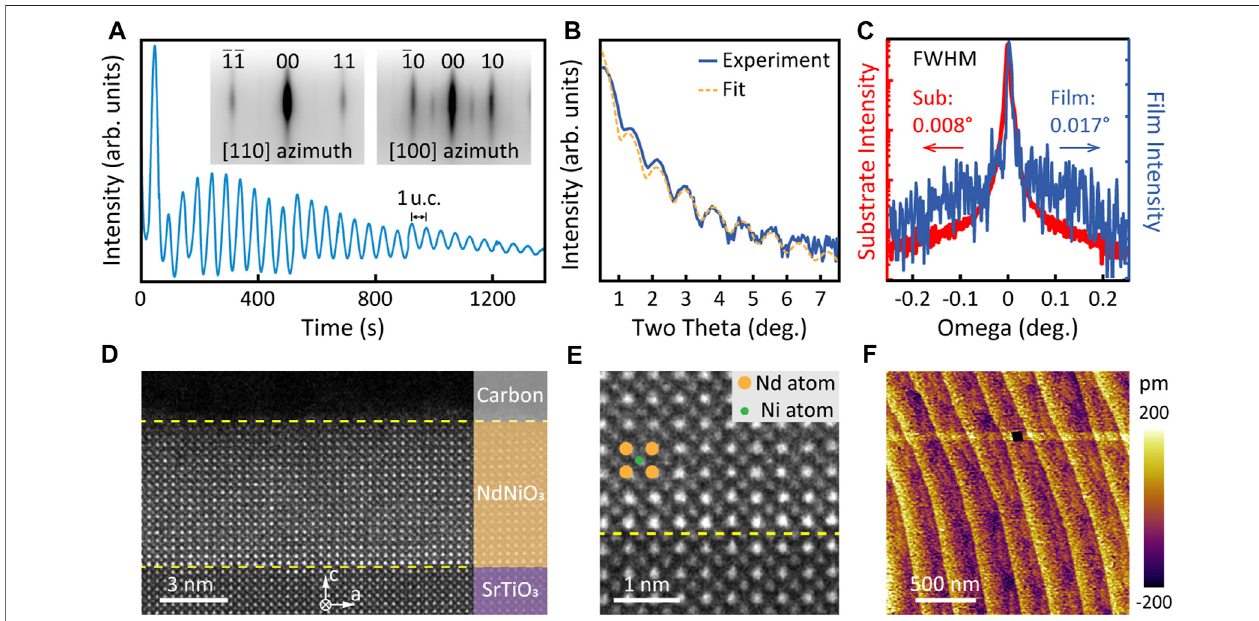
FIGURE2| StructuralcharacterizationsofoptimalNdNiO 3 fi lms. (A) RHEEDintensityoscillationstakenalongthe(110)directionandRHEEDpatterns(inset)ofa27 u.c. thick NdNiO 3 fi lm grown on SrTiO 3 substrates. The period of the oscillations denoted by the arrow indicates the time needed for the growth of one-unit-cell-thick NdNiO 3 by the co-deposition mode. (B) Magni fi cation of the high-resolution XRD 2 θ - ω scan of the 27 u.c. NdNiO 3 fi lm at a low incident angle with clear Kiessig fringes, andthecorresponding fi tof fi lmthicknessisshownastheyellowdashedline. (C) RockingcurvesoftheNdNiO 3 fi lmandSrTiO 3 substrate.ThevaluesofFWHMare both obtained in a linear scale. (D, E) Cross-sectional STEM-ADF images of an 18 u.c. thick NdNiO 3 fi lm on SrTiO 3 substrates under different magni fi cations. (F) A representative AFM image of the surface morphology showing clear terraces of the NdNiO 3 fi lm.